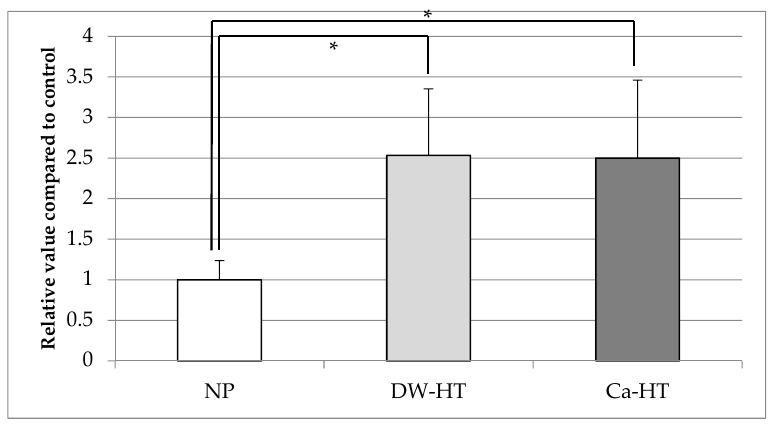
Figure 2. Recombinant human osteopontin (rhOPN) adsorption. There were statistically significant differences among the groups ( p < 0.01).